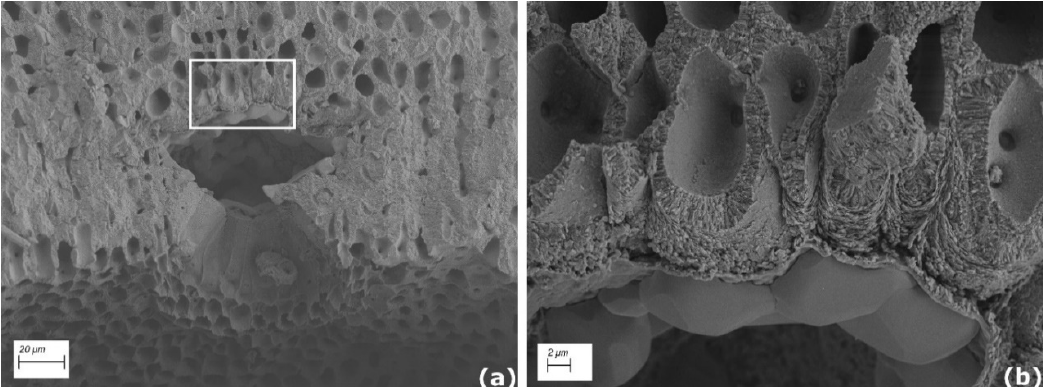
Figure A1. Examples of SEM images that were not assigned to a specific category: ( a ) Lithophyllum racemus pore canal; ( b ) a magnification showing perithallial cells near the pore canal. These features proved to be significant contributors to the correct classification of Lithophyllum spp. in the 2 and 3 class − CNNs.